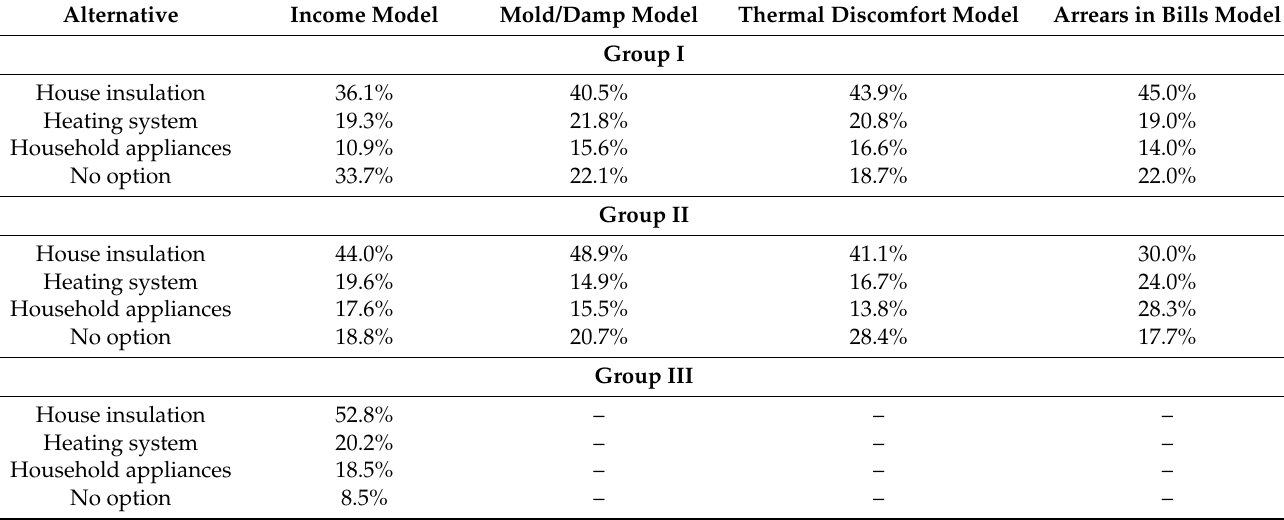
Table 6. Choice probabilities for each alternative per model and